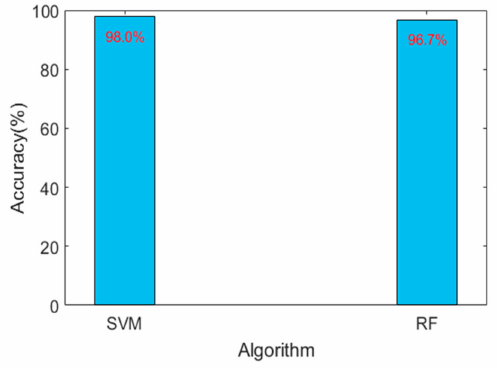
Figure 8. Algorithm